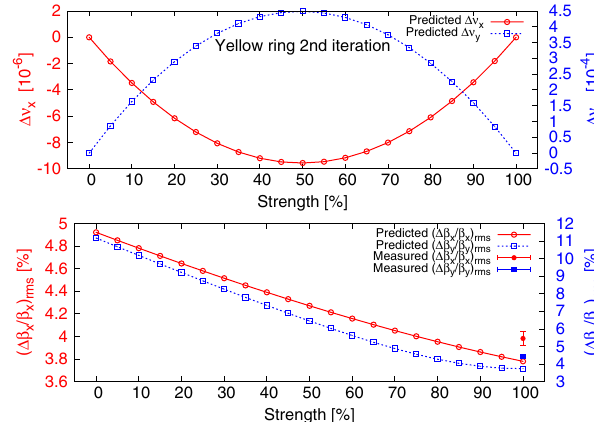
FIG. 7. Baseline and corrected horizontal beta-beat with error bars for the Yellow ring. The peak beta-beat was reduced from 15% to 12% after the first iteration of correction, and further reduced to 10% after the second iteration.